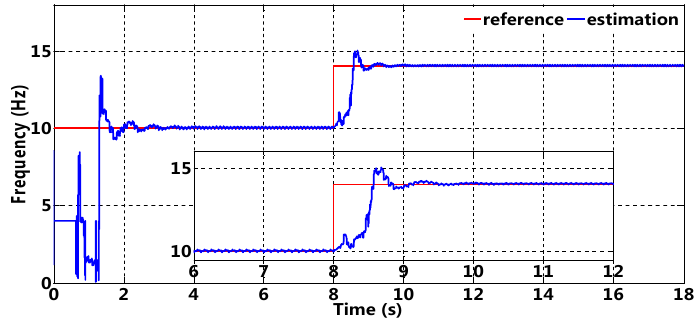
Figure 14. Fundamental frequency